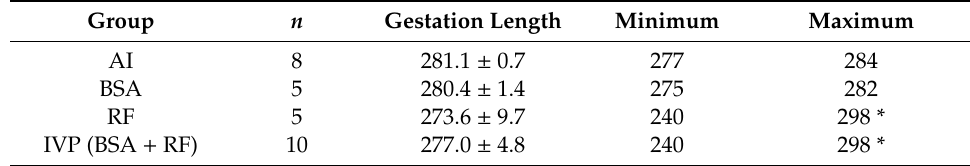
Table 3. Gestation length of non-induced parturitions from pregnant cows of artificial insemination (AI), bovine serum albumin (BSA), reproductive fluids (RF) or in vitro-produced (IVP, corresponding of BSA + RF). Group n Gestation Length AI